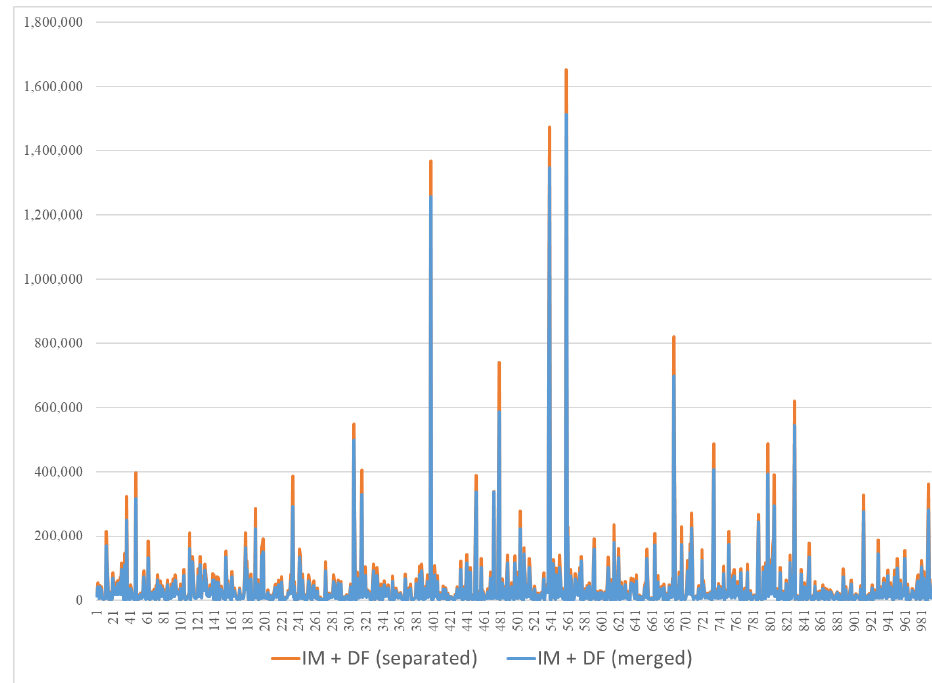
Figure 6. Total value of the guarantees in the merged and the separated case.